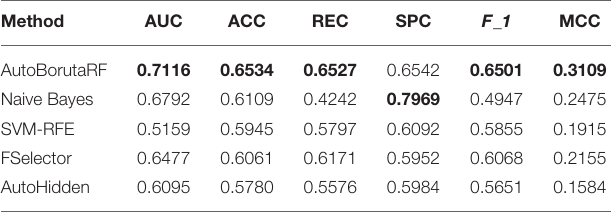
TABLE 2 | Mean values of six evaluation metrics obtained from